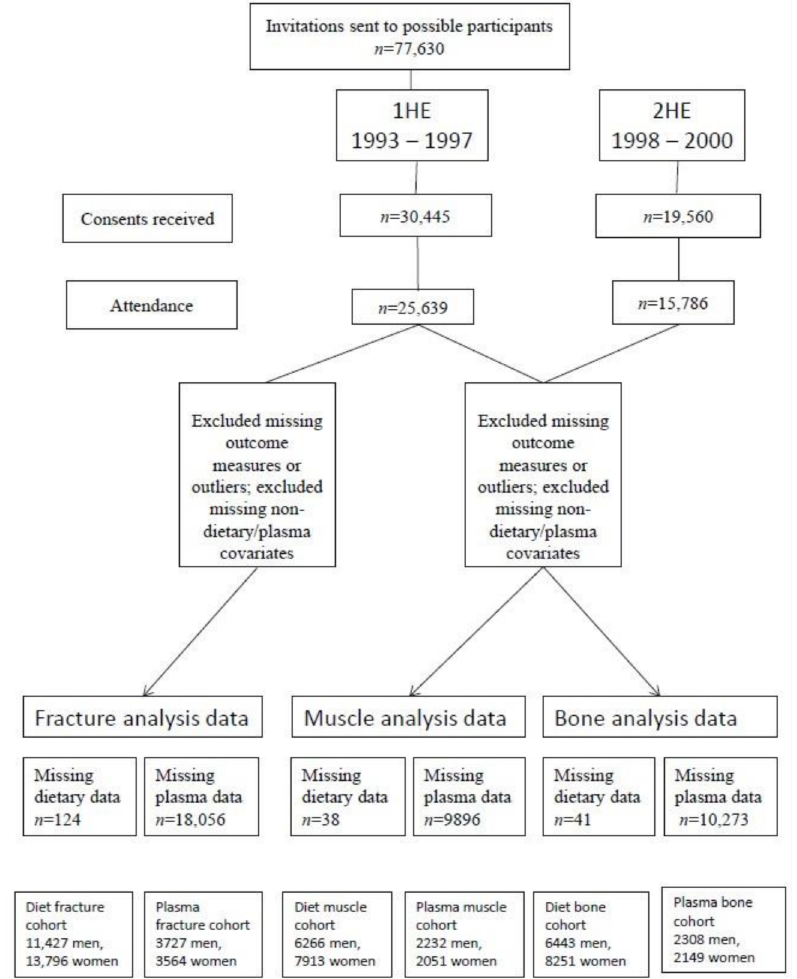
Figure 1. Flowchart of participants included in the